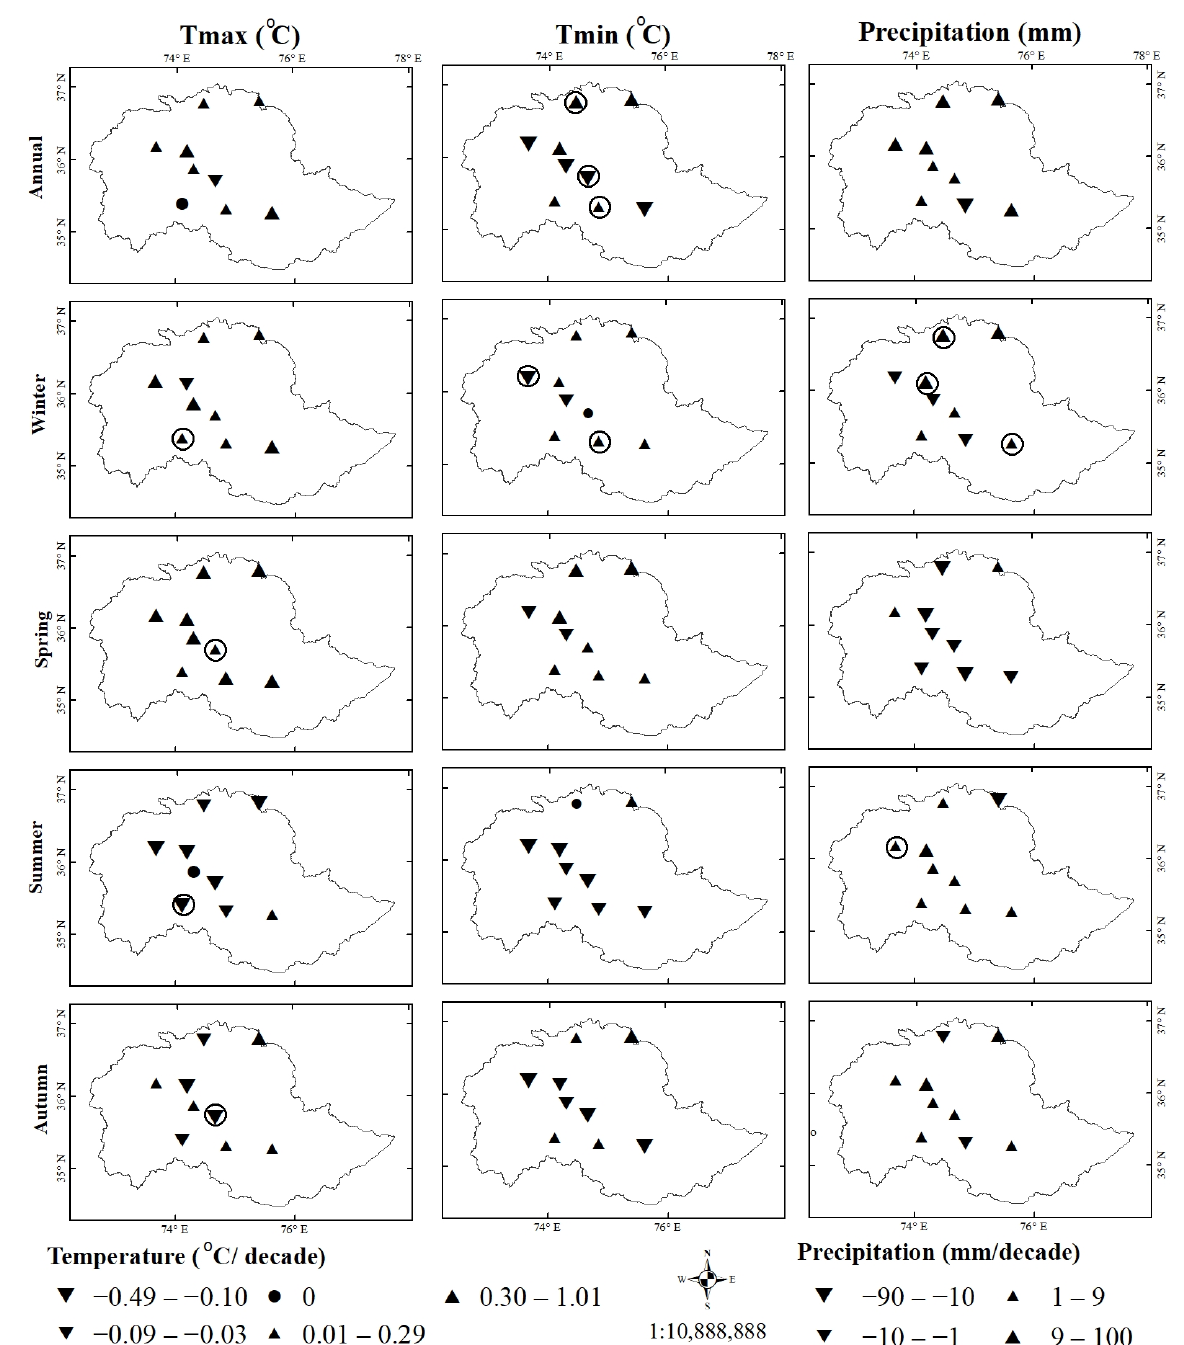
Figure 4. Spatial distribution of stations with Mann-Kendall and Sen’s test for annual and seasonal T max , T min and precipi- tation. Black circles indicate significance level at 5%. Table 4. Sen’s estimator for annual and seasonal T max , T min (°C/decade) and precipitation (mm/dec- ade) during 1955–2016 in the UIB. Bold indicates significant trend at 5% level.